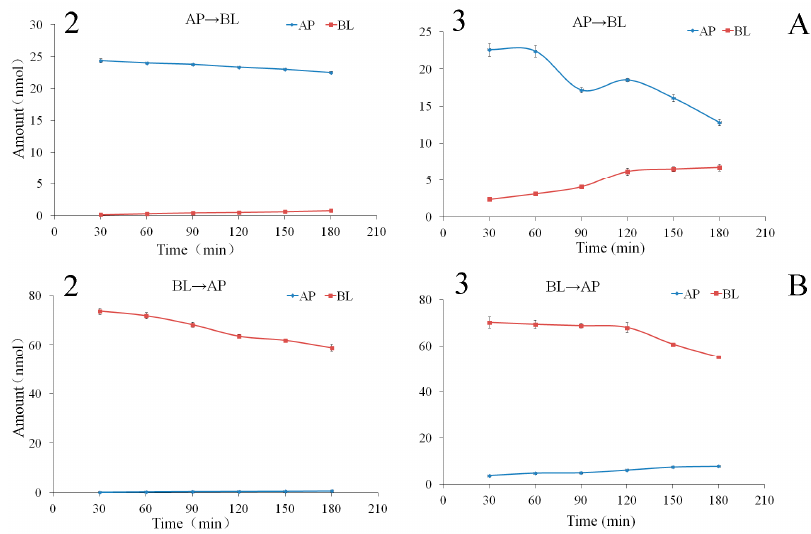
Figure 3. Kinetics curves of the compounds 2 and 3 transports in Caco-2 monolayer from apical to basolateral direction at 50 µM. ( A ) AP → BL, ( B ) BL → AP. Data are the mean ± S.D ( n = 3).